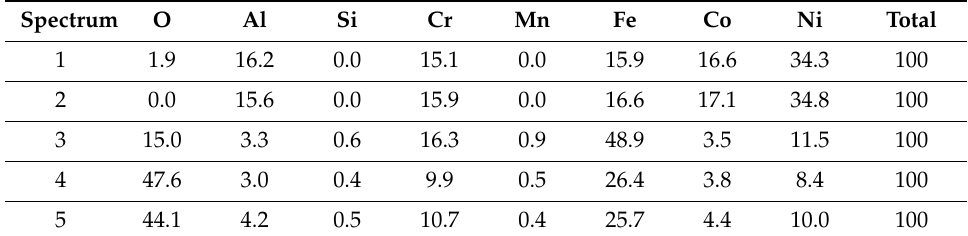
Table 3. Elements concentration in at% from EDS point analyses in Figure